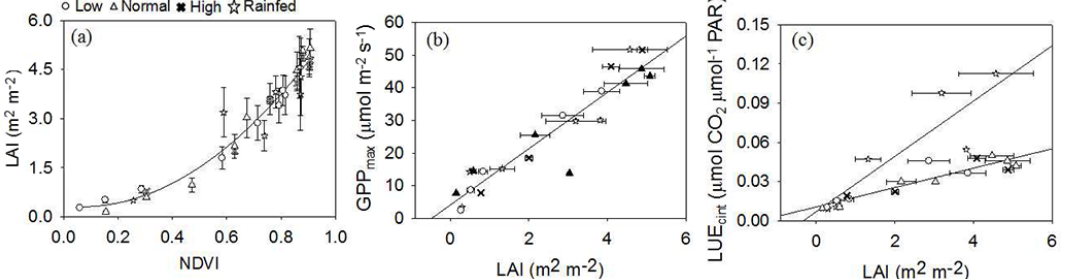
Figure 3. Correlations between (a) normalized difference vegetation index (NDVI) and LAI, (b) GPP max and LAI, and (c) canopy light use efficiency (LUE cint ) and LAI across the PD low-, normal-, and high-nutrient groups, and in the RF rice. Mean ± SD, n = 3 to 6. PD: paddy; RF: rainfed.